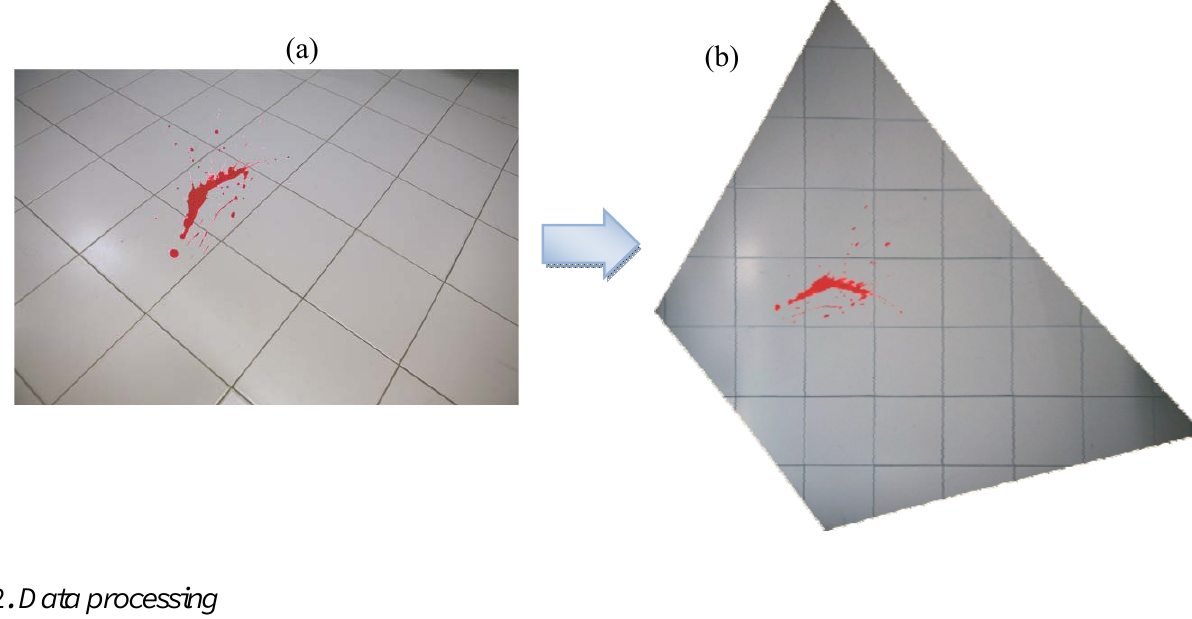
Figure 7. (a) Non metric image; (b) Rectified